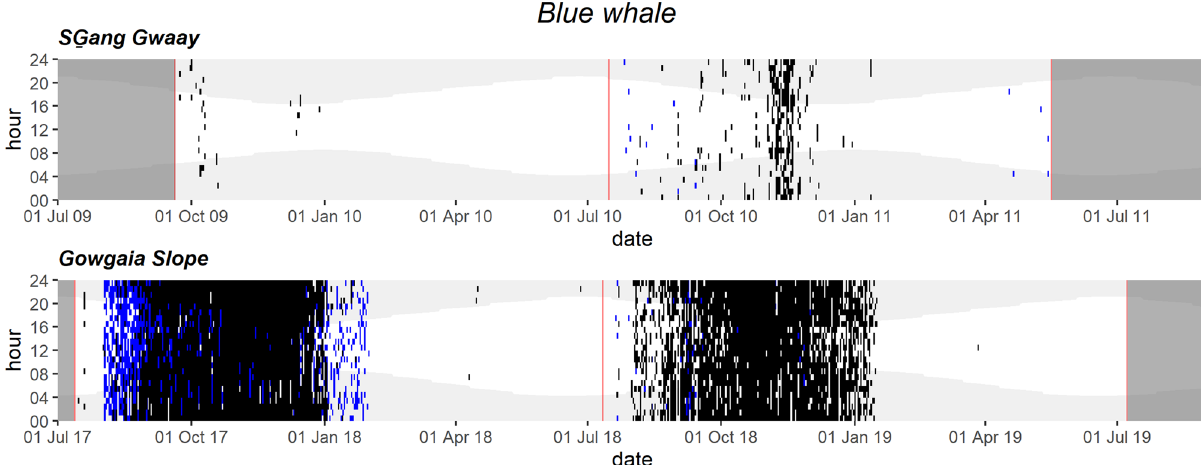
Figure 4. Daily and hourly occurrence of blue whale vocalizations at SG ̱ ang Gwaay and Gowgaia Slope in 1-h bins. Blue dots indicate automated detections. Black dots indicate confirmed occurrence. Red lines indicate recorder deployment and retrieval dates. Dark grey areas indicate a lack of recordings. Light grey shaded areas indicate hours of